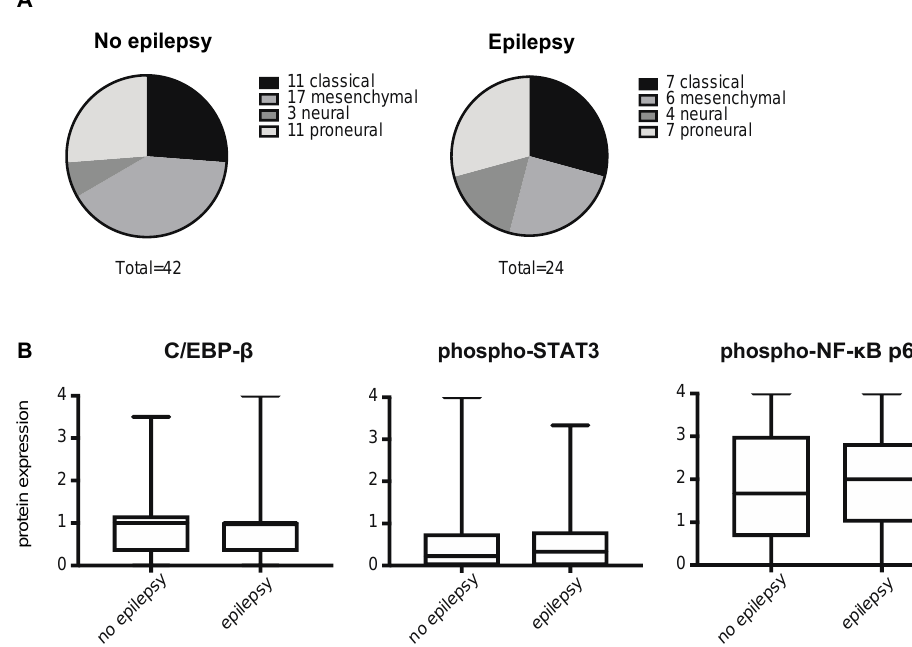
Figure 3. Molecular subclassification and mesenchymal activation in epileptogenic GBM. ( A ) Distribution of molecular GBM subtypes in subgroup of patients with epilepsy ( n = 24) and without epilepsy ( n = 42), based on mRNA expression profile. There was no significant difference in subtype distribution (Chi-square test, p = 0.48). ( B ) Protein expression of CEBP- β , phosphorylated STAT3 and phosphorylated NF- κ B p65 on GBM tissues included on a tissue microarray. Mann Whitney U test did not show significant differences in protein expression between the epilepsy and non-epilepsy subgroups (CEBP- β : n = 266, p = 0.81, phosphorylated STAT3: n = 272, p = 0.68, phosphorylated NF- κ B p65: n = 278, p = 0.56). Boxes represent median and quartiles, whiskers show data range.